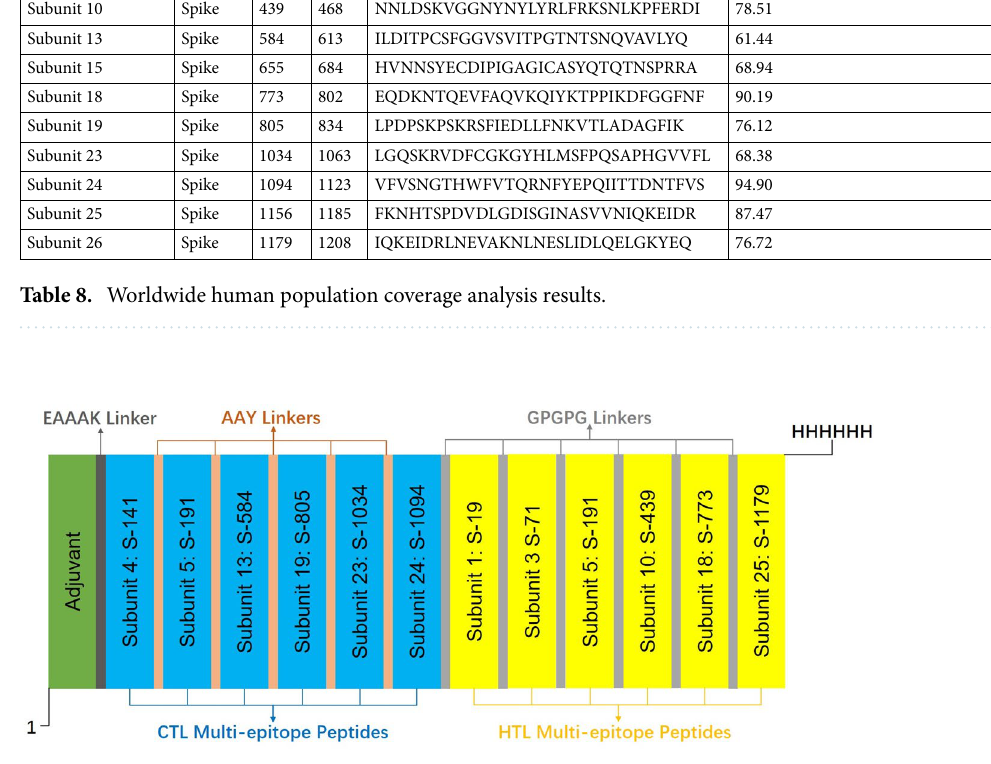
Figure 4. Schematic Presentation of the final Multi-epitope Vaccine. The vaccine is constructed by 11 subunits (Subunit 5 is used twice in both CTL and HTL region for its good performance), an adjuvant and a 6xHis tag, linked by EAAAK, AAY and GPGPG linkers. The final vaccine consists of 694 amino acid residues. It contains 16 B-cell epitopes, 82 CTL epitopes and 89 HTL